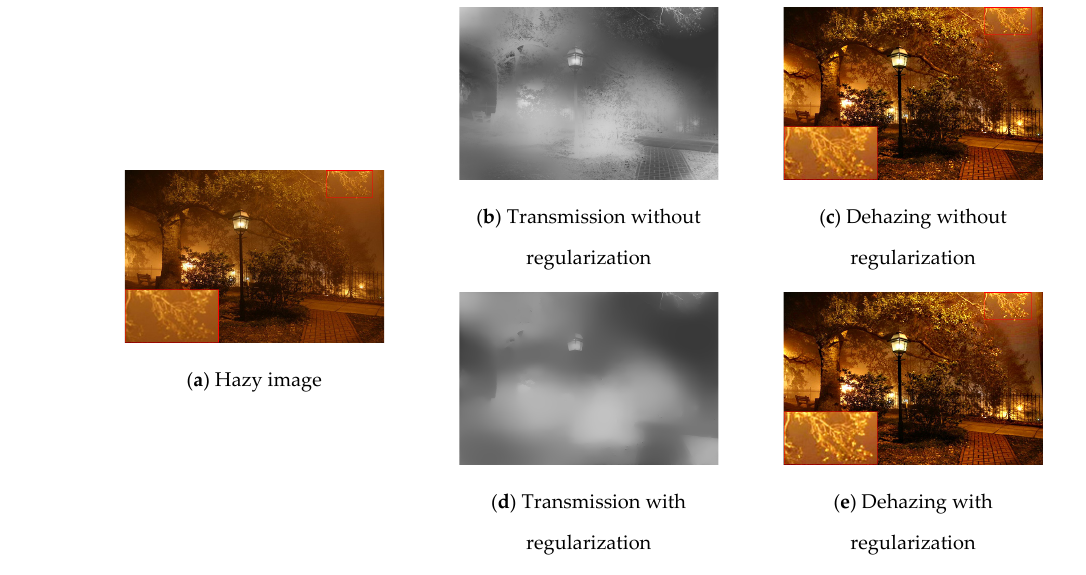
Figure 4. Comparison of regularizan.